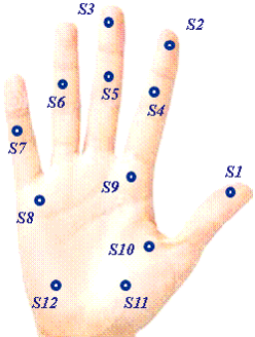
Figure 1. Sensor locations